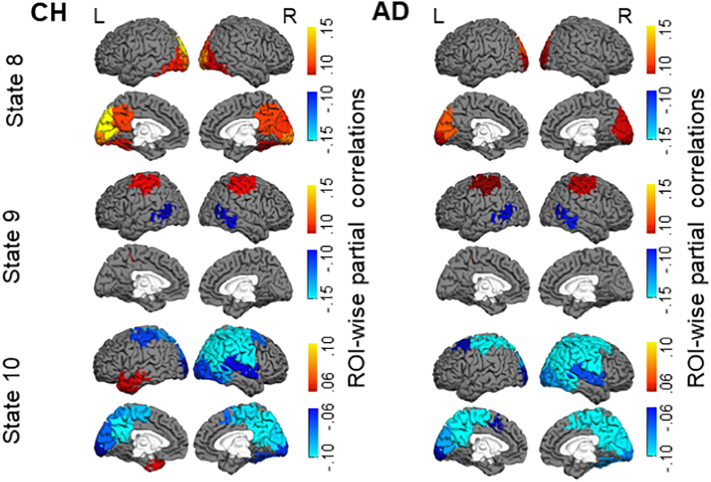
Maps of state-specific increases (in yellow/red/brown colors) and decreases (in blue color) in oscillatory amplitudes during three least salient (transitional) network states inferred by the HMM. Each map shows partial correlations between the state time-course and the oscillatory amplitude envelopes in the a priori ROIs. Maps in the CH group are shown in the left panel and in the AD group in the right panel. Abbreviations are the same as in Fig. 2.